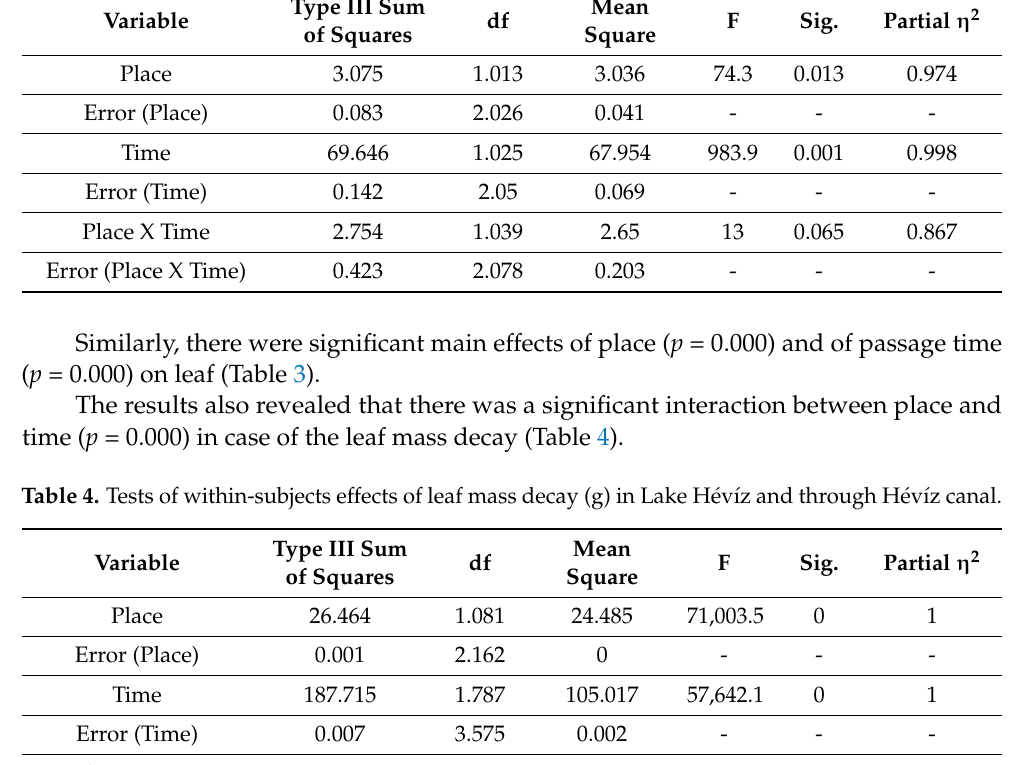
Table 4. Tests of within-subjects effects of leaf mass decay (g) in Lake Hévíz and through Hévíz canal. Variable